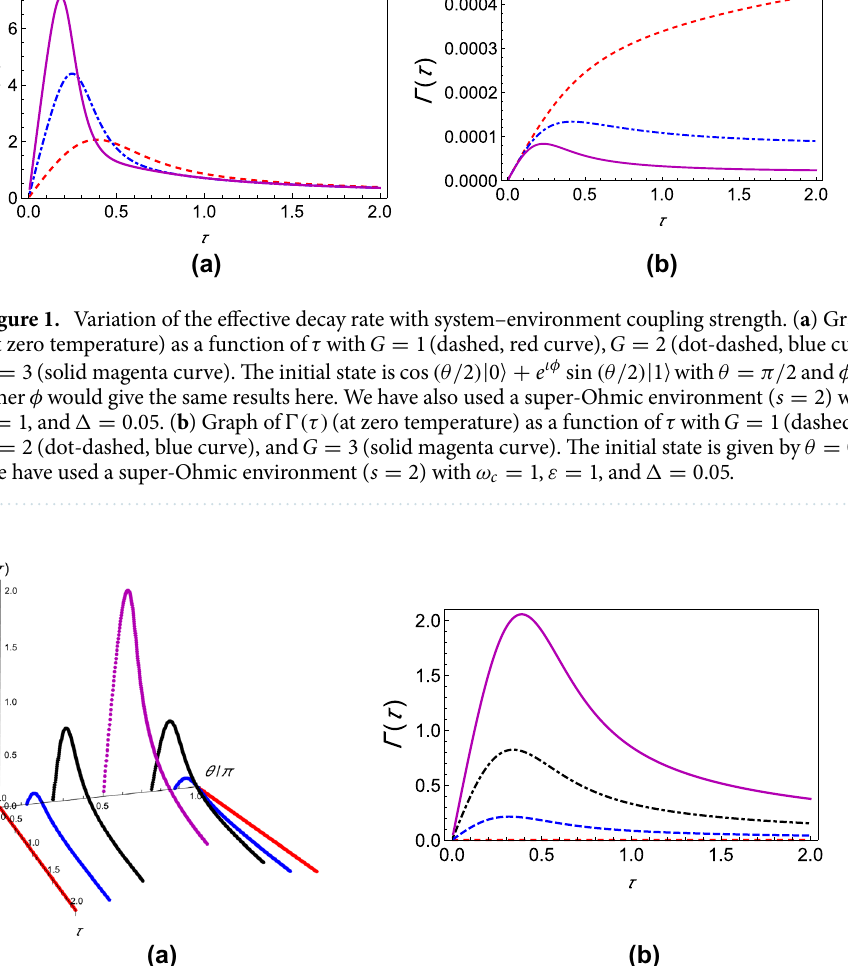
Figure 2. Variation of the effective decay rates with the initial state of the two-level system. ( a ) The effective decay rate Ŵ(τ) (at zero temperature) as a function of τ for different initial states. θ takes values from 0 through π , but φ is kept 0 for the sake of simplicity. ( b ) Ŵ(τ) - τ cross-sections of ( a ) for θ θ π/ 8 (dashed, blue curve), θ = used a super-Ohmic environment ( s